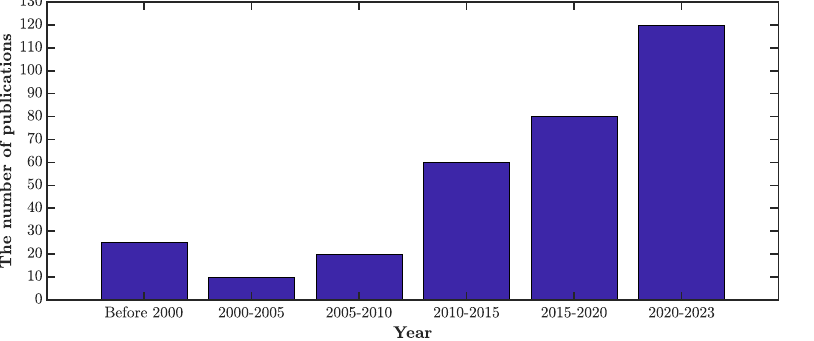
Figure 1. The process for selecting, researching, and analyzing relevant research papers.